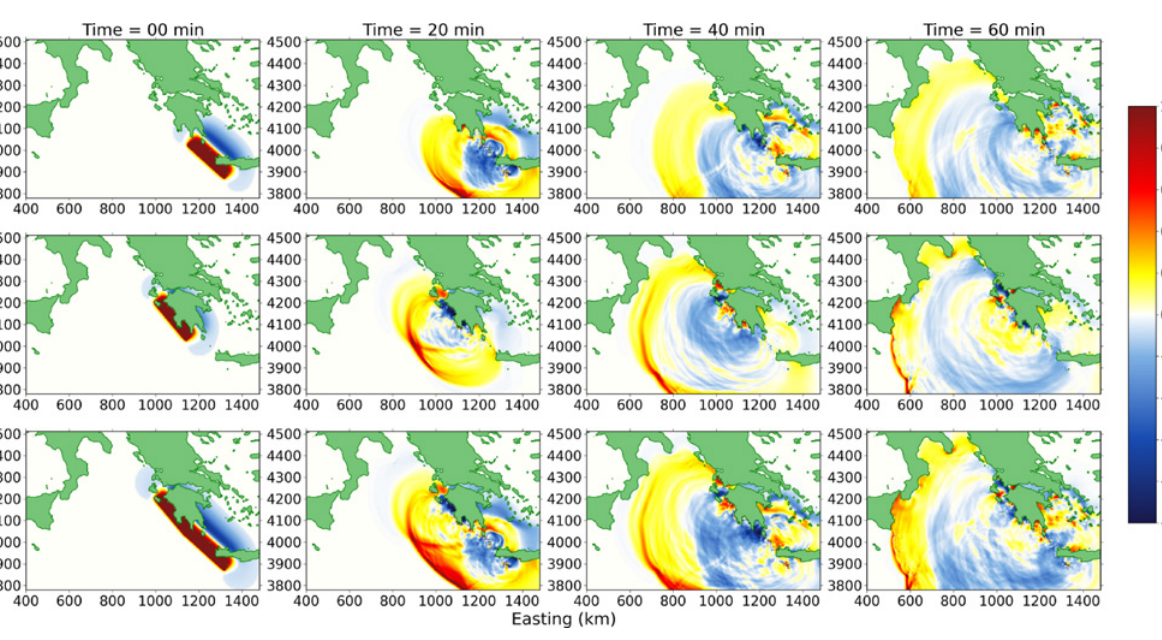
Fig. 6. Tsunami propagation snapshots for 365 F1 (upper panels), 365 F2 (middle panels), and 365 F3 (bottom panels)